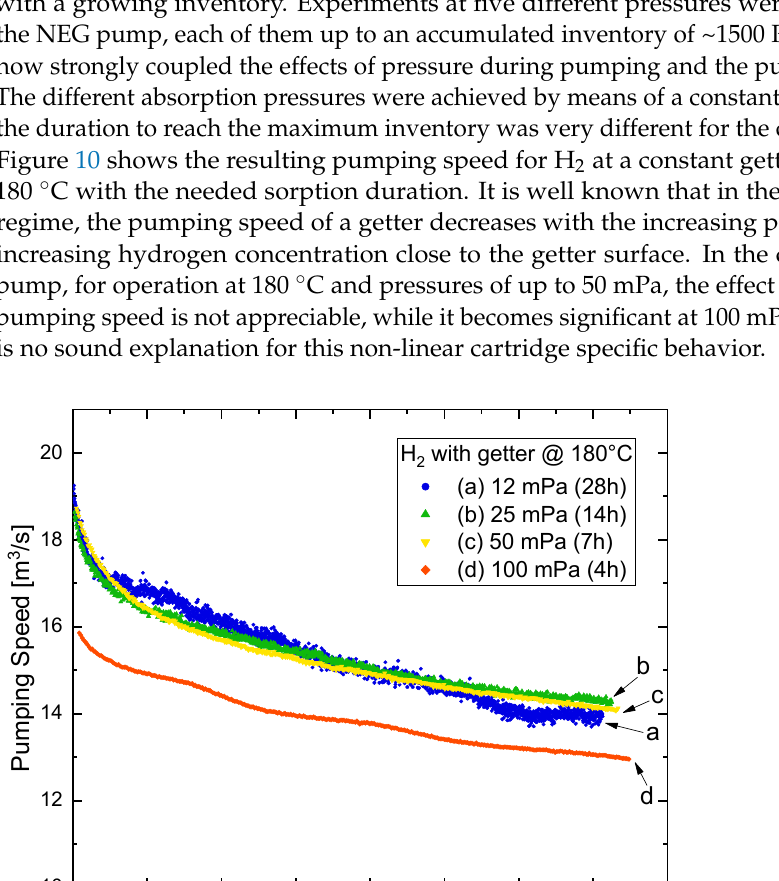
Figure 11. Pumping speed curves at different pressures with a growing inventory of H 2 with ZAO ® at temperatures of 70 °C or below. 5.2. Getter Temperature Influence Clearly, the getter is working also at ambient temperature, where it is preferred from a pure energy consumption point of view. However, its capacity for non-hydrogens in- creases significantly with higher temperatures. Furthermore, its potential capability to preserve the performance for hydrogen under a non-hydrogen impurity background is improved. Hence, the choice of the ideal getter temperature during pumping results from a trade-off, which considers thermal aspects with performance aspects. In support of this, an experimental campaign was conducted at different getter temperatures and the other parameters remained constant. In Figure 12, the pumping speed values of each of these experiments at a rather low inventory of 133 Pa·m 3 /kg are summarized. Based on this, the getter temperature of 180 °C was decided to be chosen for the standard experiments, along